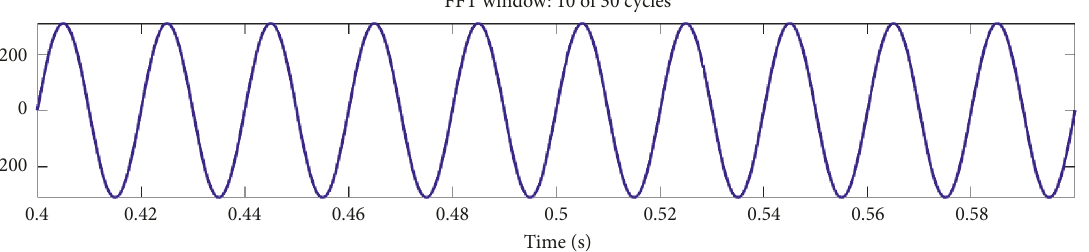
Figure 29: The source voltage (Vs) waveform. FFT window: 10 of 30 cycles